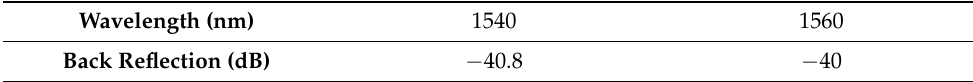
Figure 8. Monitor placement illustration in FDTD simulation. Table 3. Back-reflection loss for the operating